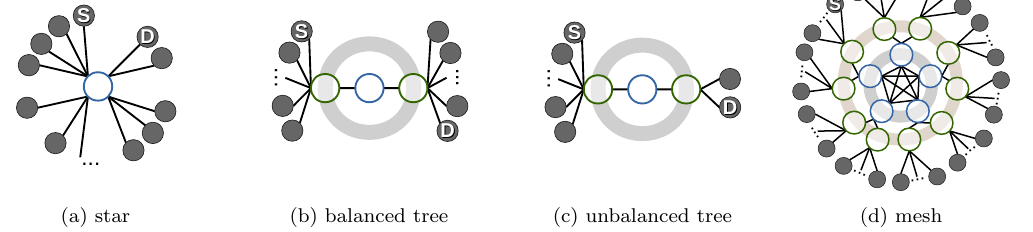
Figure 4: Topologies used for performance comparison. The nodes S, and D are the hosts used to install OnOffApplication and PacketSink applications, respectively.